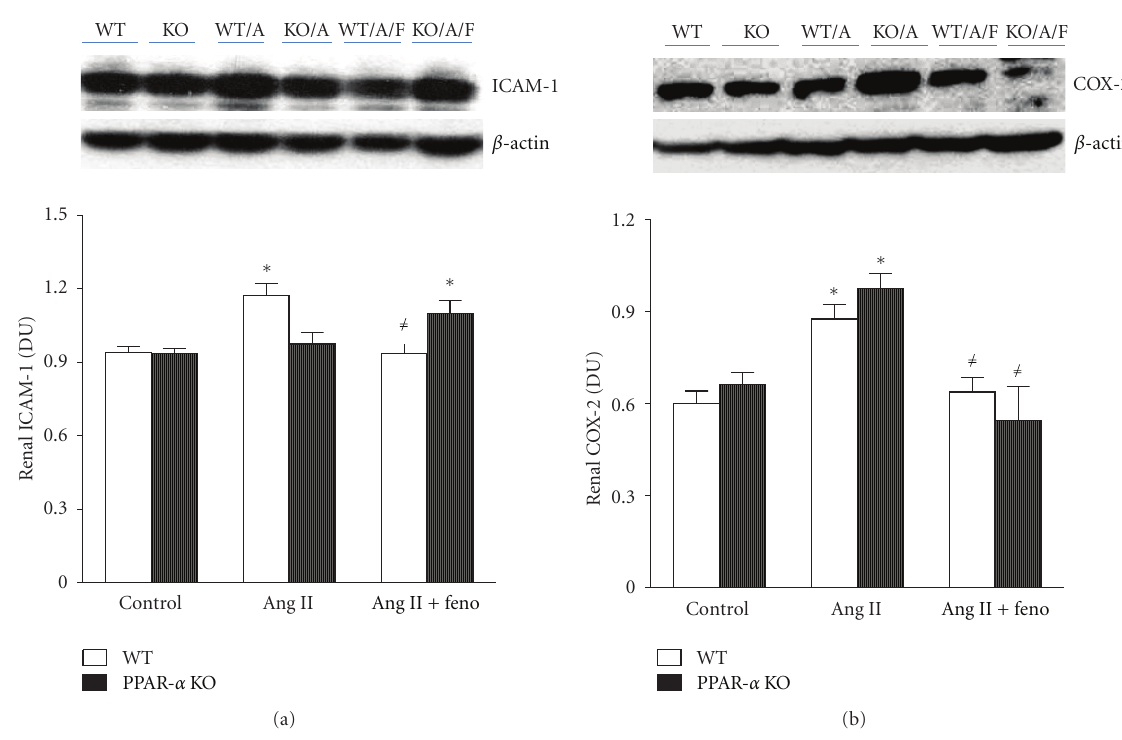
Figure 4: Renal ICAM-1 and COX-2 protein expression levels relative to β -actin as markers of renal inflammation in WT and PPAR α KO control, Ang II-infused and Ang II-infused + fenofibrate-treated mice. ∗ indicates a significant increase versus control WT mice and # indicates a significant increase versus Ang II-infused WT mice ( n = 4 per